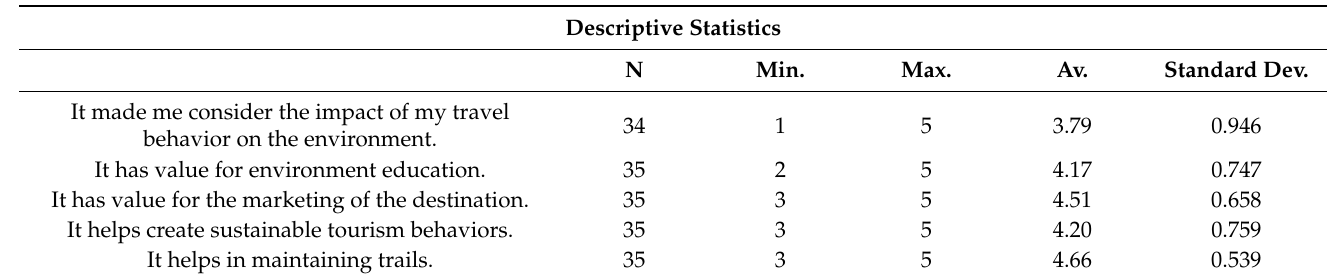
Table 4. Reactions of tourists directly involved in the volunteer tourism project, PS Imago Pro, own